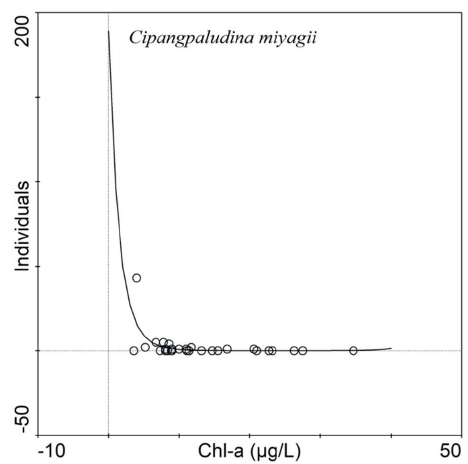
Figure 8. Response of C. miyagii to Chl-a (µg/L) in 30 surface sediment samples under GLM (generalized linear model).